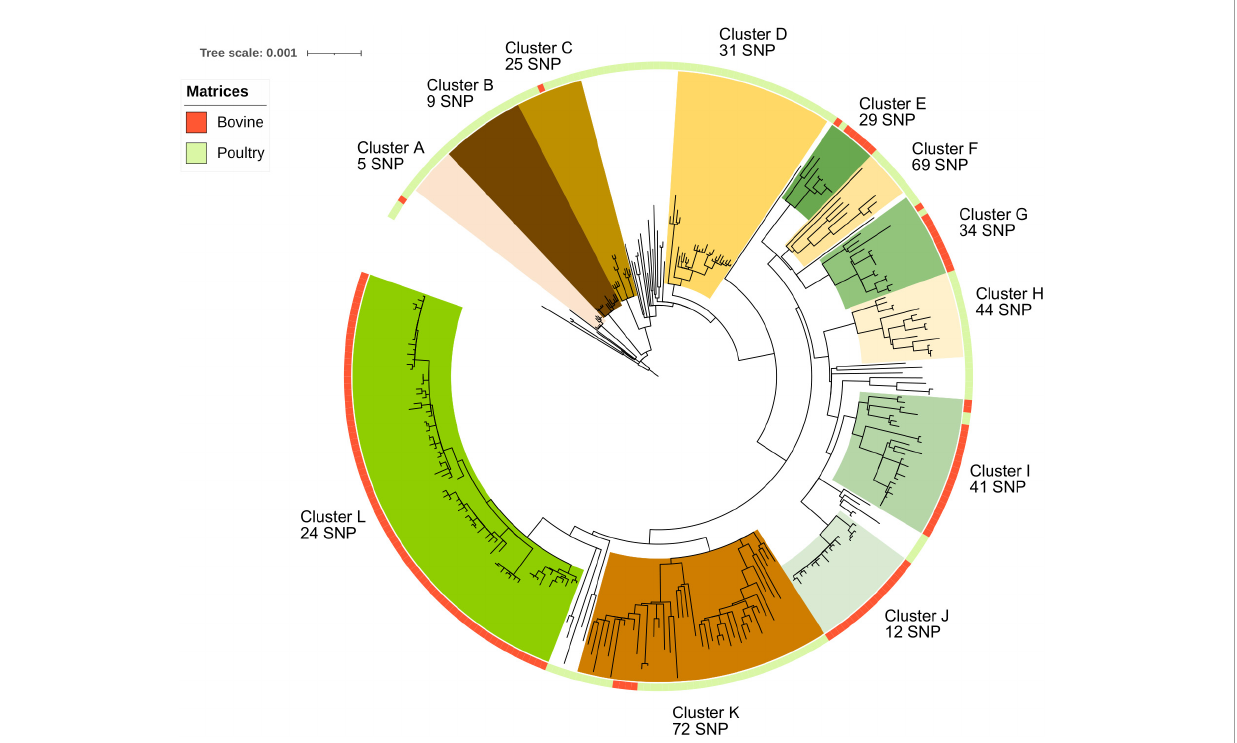
FIGURE1 Phylogenetic reconstruction based on core-genome single nucleotide polymorphism substitutions of the 304 Salmonella Mbandaka strains isolated in France between 2016 and 2021 from the bovine and poultry sectors. The maximum likelihood criterion and the transversional model TVM + F model were applied. Salmonella Mbandaka SA20026234 was used as the reference complete genome. The source of the strains (bovine and poultry) is indicated in the ring around the tree. The 12 genomic groups identified with their intergenomic mean SNP values are indicated by different names and colors for a better